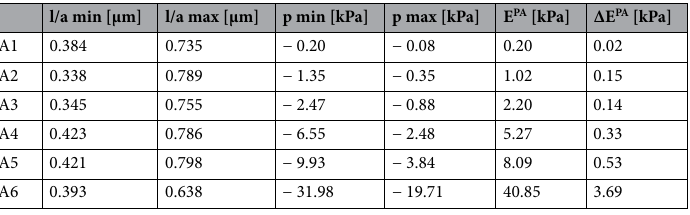
Table 3. Minimum and maximum values of ratio l/a (and relative pressures) measured by micropipette aspiration for each gel. The mean values of the elastic moduli E PA calculated for each value of p and l/a is reported together with their standard